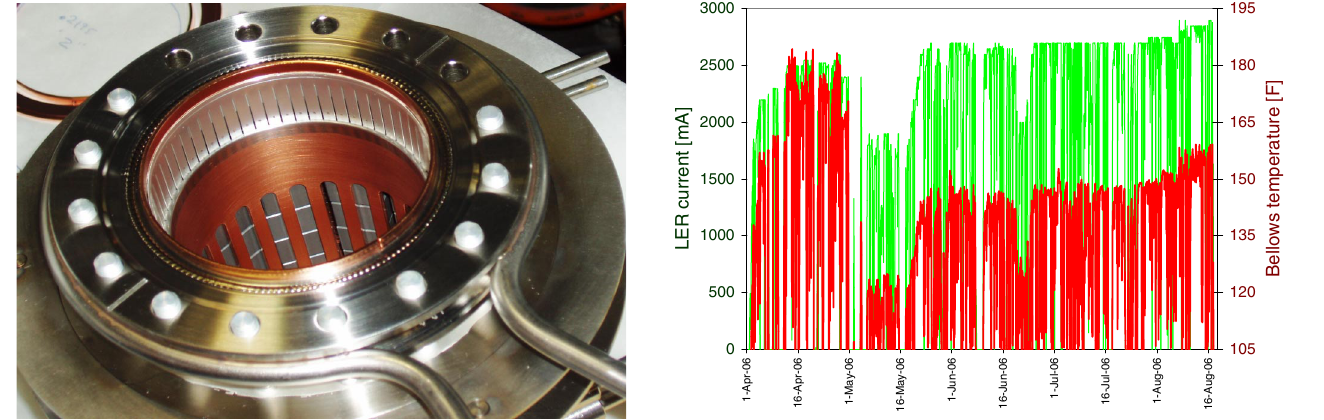
FIG. 13. (Color) Bellows